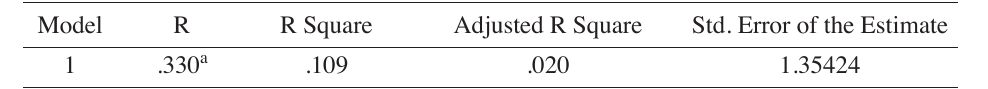
Table 7: Model Summary Analysis